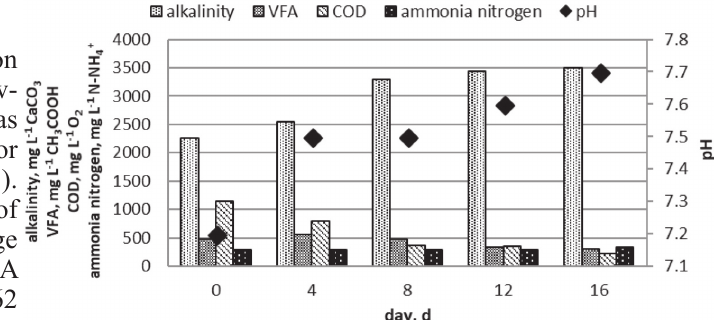
Fig. 2 – changes in the concentration of VFA, alkalinity, CODdiss, ammonia nitrogen, and pH in the mixture of munici- pal sludge with coke sewage sludge during co-digestion (mix - ture